Question: Condense the content of this figure into a single sentence.
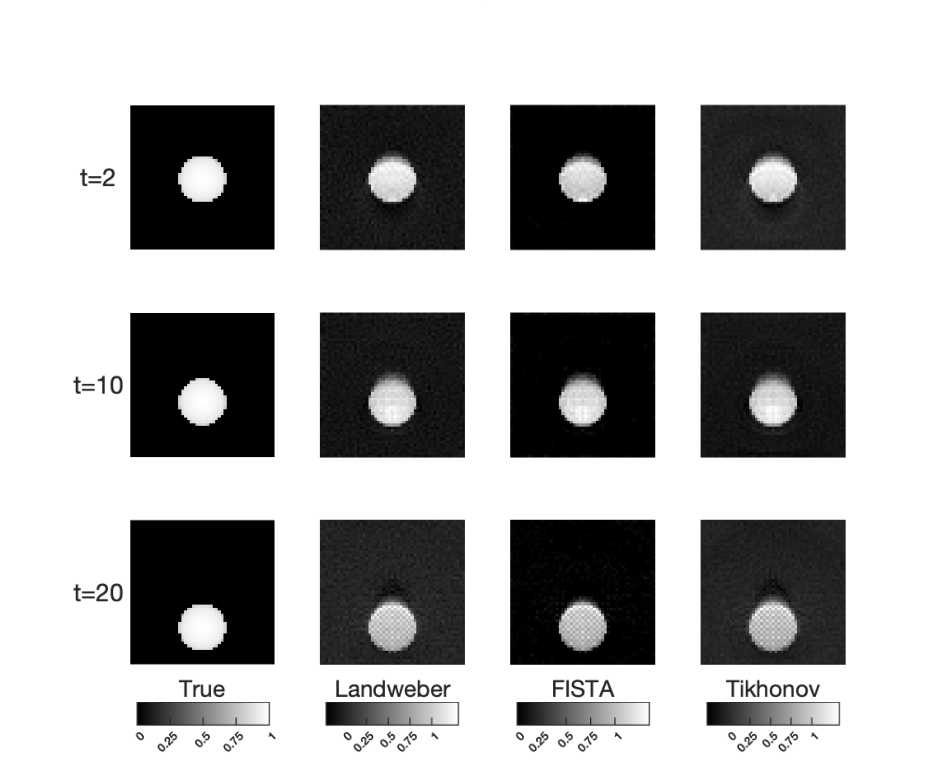
Answer: Reconstructed string for Example #1 when terminated according to the DP at corre- sponding time slices with 5% noise, a = 0.05, and c = 1.5 for each method considered.